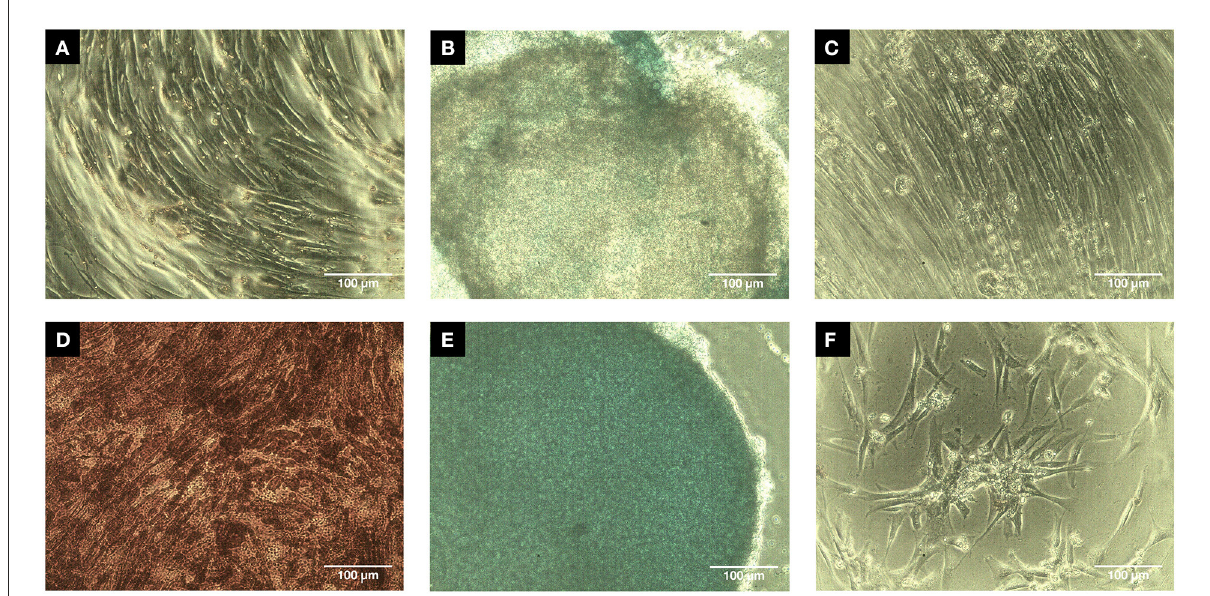
FIGURE1 Trilineage assay micrographs (Scale bar = 100 µ m). Passage 2 canine MSCs were successfully induced after 14 days into osteogenic differentiation (D) as mineralization was positively stained while the control (A) had no positive staining for Alizarin red. Similarly, chondrogenic differentiation was successfully induced after 21 days as indicated by intensity of positive Alcian blue staining (E) compared to the control (B) which only had partial positive staining. The adipogenic differentiation after 14 days was negative (F) with no Oil Red staining in comparison with the adipogenic differentiation control (C)